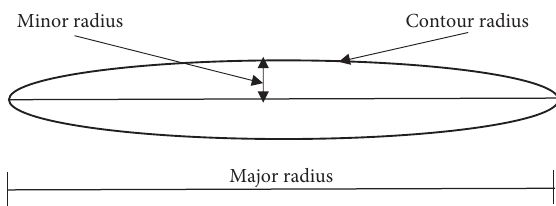
Figure 6: Semielliptical